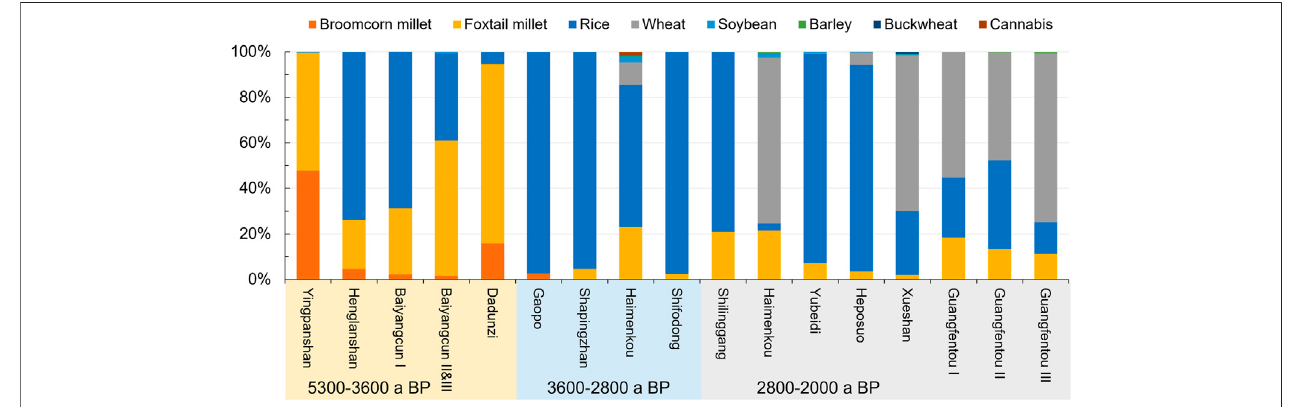
FIGURE 4 | Diachronic charts of crop patterns in the Zang-Yi Corridor of southwest China.